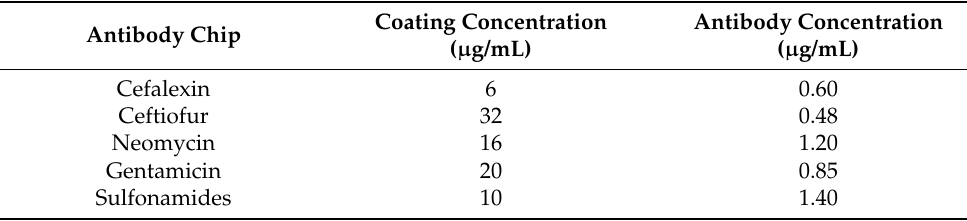
Table 1. The optimal concentrations of antibody and antigen for the antibody chips.